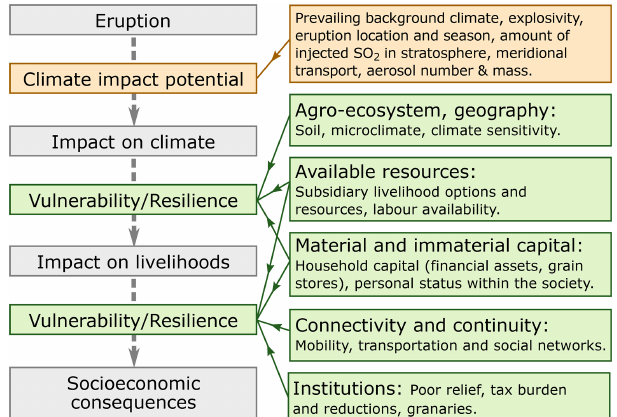
Figure 7. Conceptual model linking eruption events to socioeco- nomic consequences (left), eruption characteristics influencing the climatic impact (right, orange), and components of vulnerability and resilience (right, green), which dictate the degree of socioeco- nomic